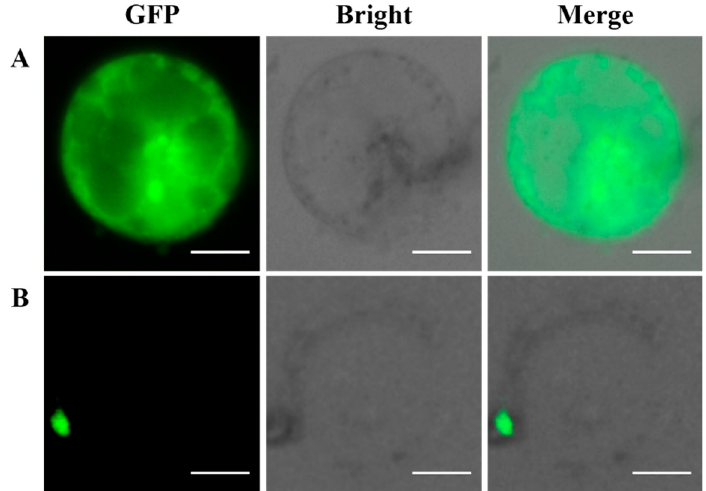
Figure 8. Subcellular localization analysis of the ( A ) green fluorescent protein (GFP) only and ( B ) MYB10–GFP vectors in Chinese kale hypocotyl protoplasts under a fluorescence microscope. Scale bars = 20 μ m.